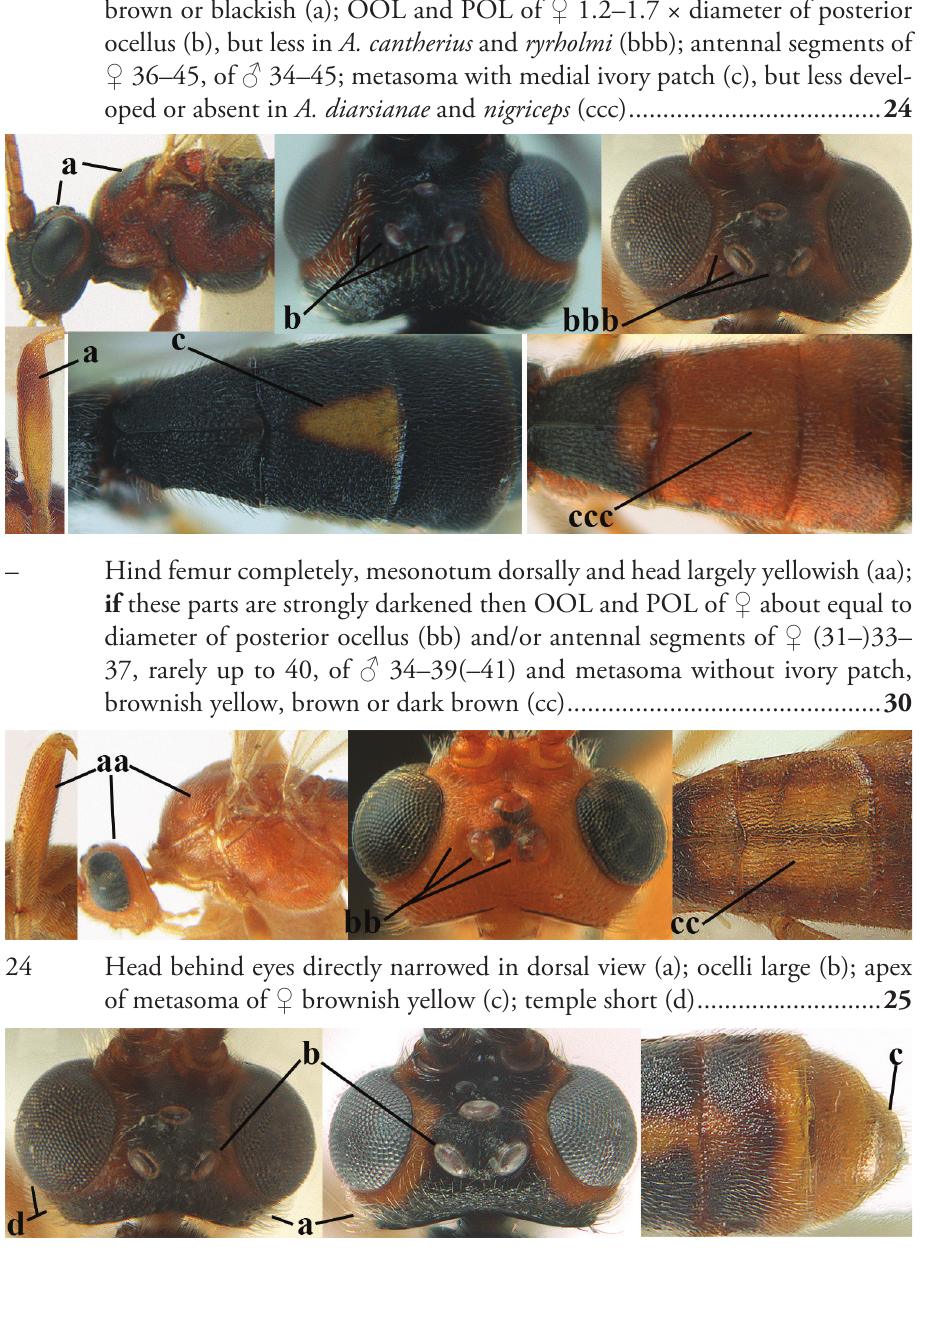
Hind femur often partly, mesonotum dorsally and/or head largely dark brown or blackish (a); OOL and POL of ♀ 1.2–1.7 × diameter of posterior ocellus (b), but less in A. cantherius and ryrholmi (bbb); antennal segments of ♀ 36–45, of ♂ 34–45; metasoma with medial ivory patch (c), but less devel- oped or absent in A. diarsianae and nigriceps (ccc) .....................................